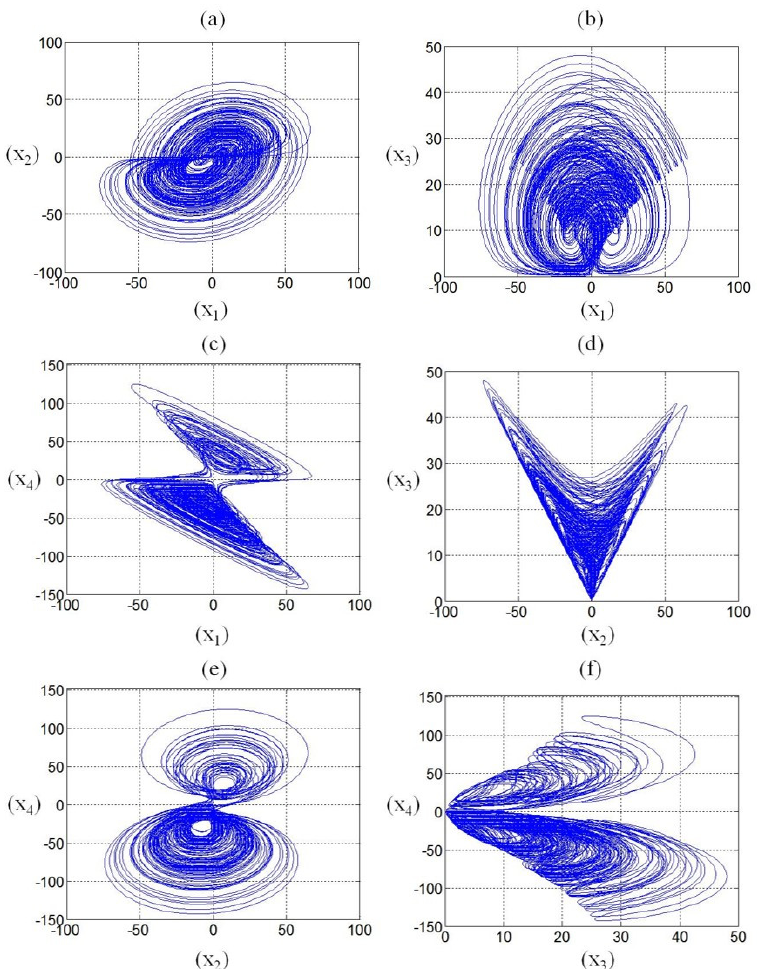
Figure 2. This 2 − D phase portraits of the four-dimensional Chen–Lee system simulated by MATLAB: ( a ) 𝑥 (cid:2869) ,𝑥 (cid:2870) plane; ( b ) 𝑥 (cid:2869) ,𝑥 (cid:2871) plane; ( c ) 𝑥 (cid:2869) ,𝑥 (cid:2872) plane; ( d ) 𝑥 (cid:2870) ,𝑥 (cid:2871) plane; ( e ) 𝑥 (cid:2870) ,𝑥 (cid:2872) plane; ( f ) 𝑥 (cid:2871) ,𝑥 (cid:2872)